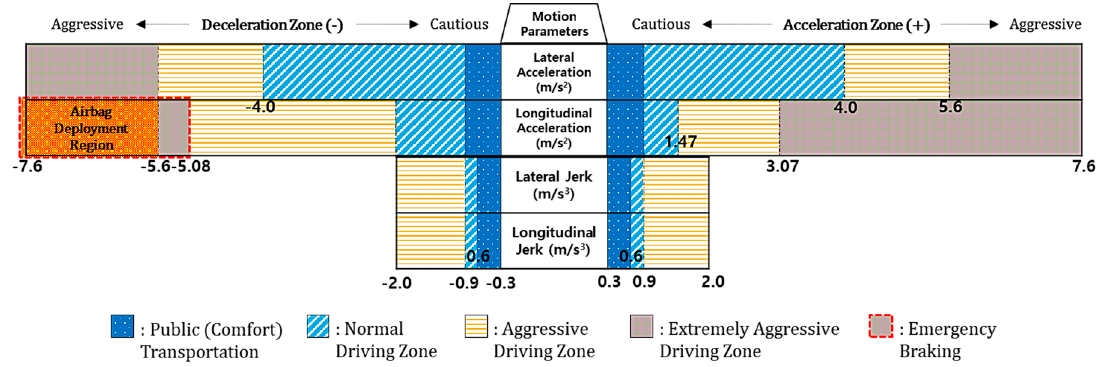
Figure 2. Typical acceleration and jerk criteria for public transportation, and typical criteria of normal, aggressive, and extremely aggressive drivers reported in prior studies [7,10–22].